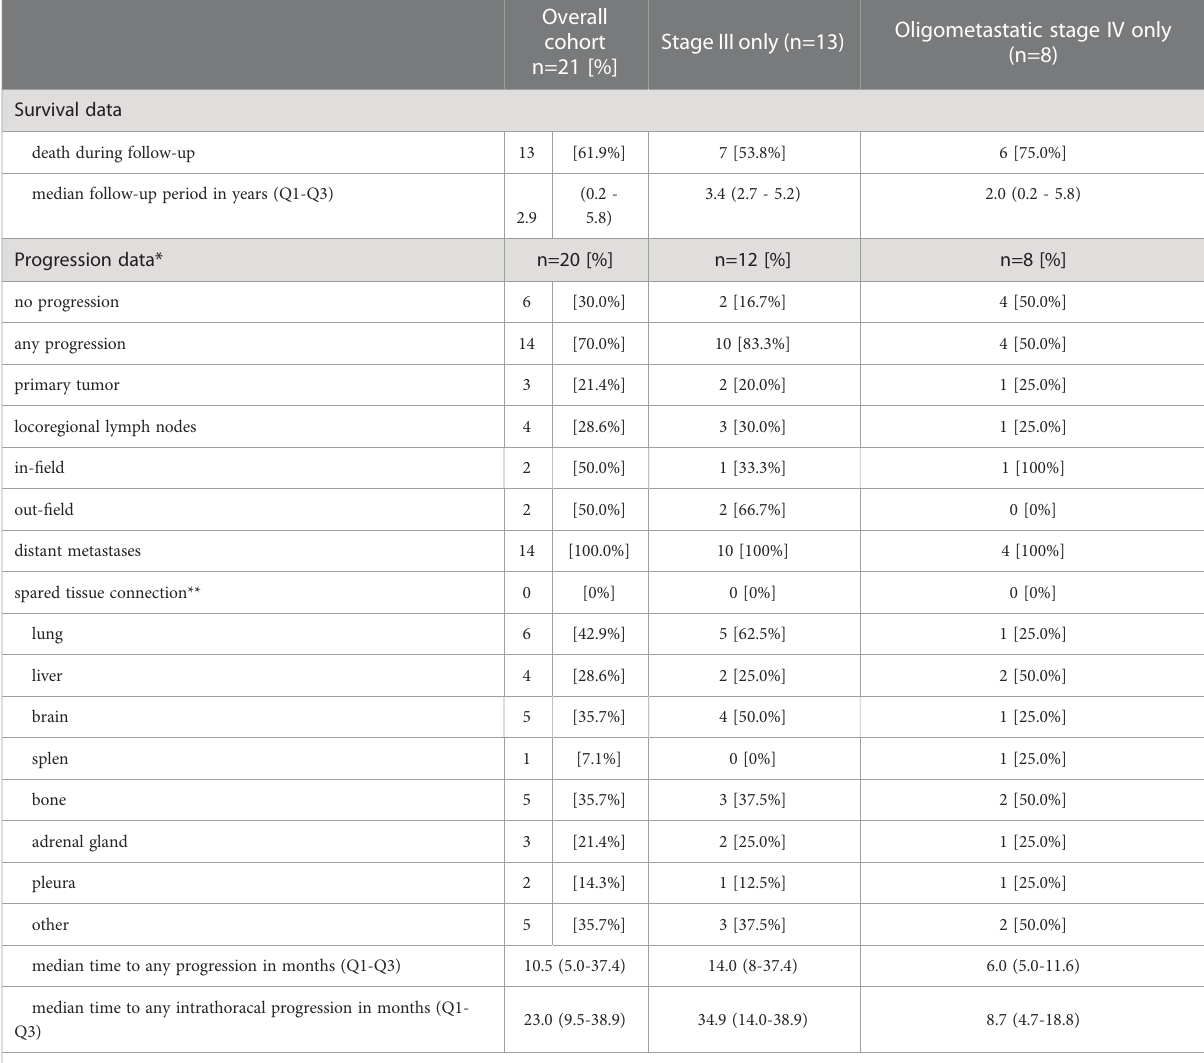
TABLE 4 Progression following radiotherapy during